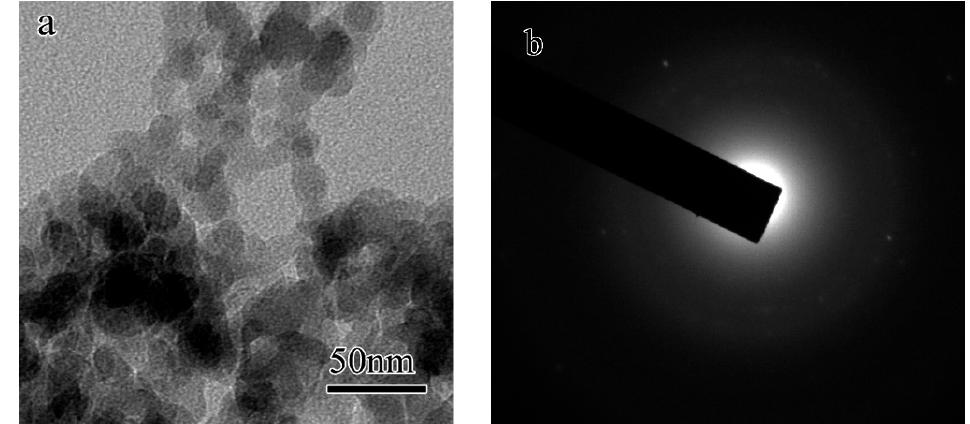
Figure 1. TEM morphology ( a ) and the corresponding diffraction pattern ( b ) of silica fume The calcined samples were characterized using a Rigaku D/Max-b (Phillips) X-ray diffractometer. X-ray diffraction (XRD) was performed using a copper target at 45 kV and 20 mA. Diffraction scans were performed from 5 to 75° at a rate of 1°/min with a step size